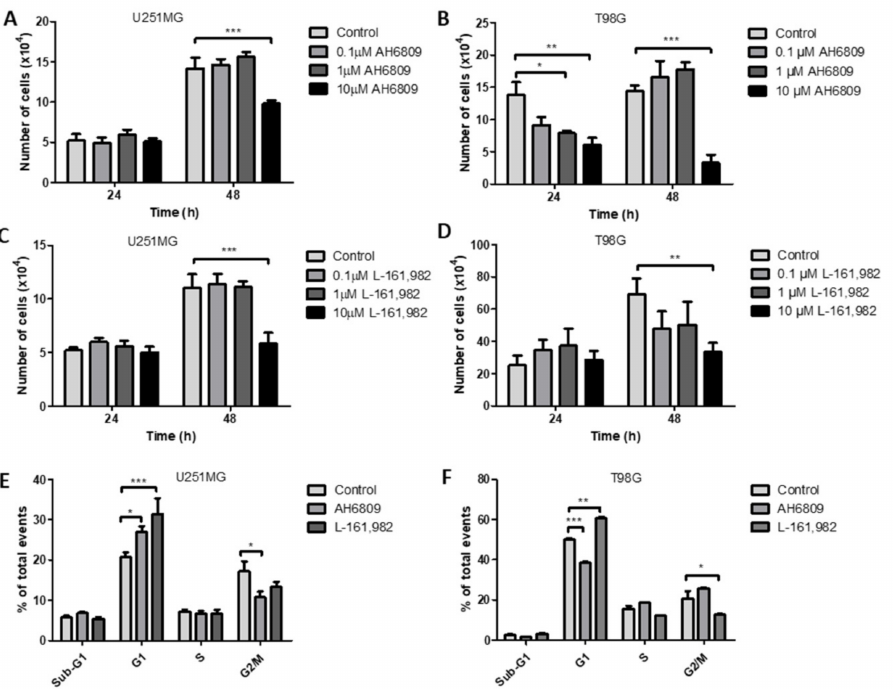
Figure 6. Effects of PGE 2 receptor EP2 or EP4 receptor antagonists, AH6809 and L-161,982, on cell counts and cell cycle distribution. Graphs show the results after 24 or 48 h of treatment with AH6809 or L-161,982 in A–D. ( A ) AH6809 in U251MG cells; ( B ) AH6809 in T98G cells; ( C ) L-161,982 in U251MG cells; ( D ) L-161,982 in T98G cells; Cells were treated with AH6809 (10 µ M) or L-161,982 (10 µ M) for 48 h before propidium iodide staining and flow cytometer analysis in E and F; ( E ) Cell cycle distribution in U251MG cells; ( F ) Cell cycle distribution in T98G cells. Data are presented as mean + SEM, n = 3. A two-way ANOVA with a Bonferroni post-test was performed. Differences were considered significant at p < 0.05. * = p < 0.05; ** = p < 0.01; *** = p <